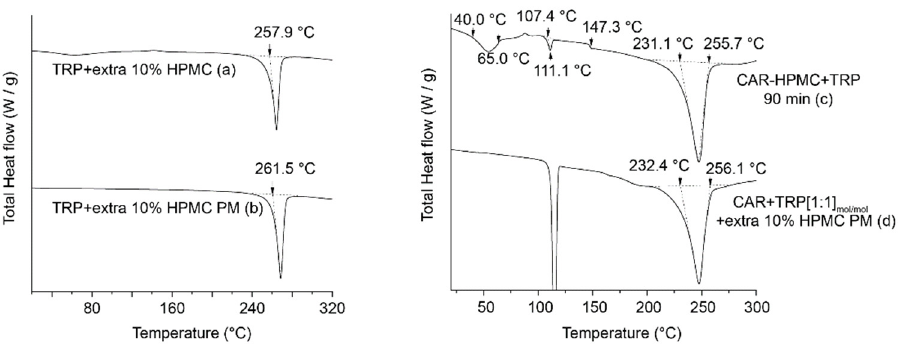
Figure 5. DSC thermograms of ( a ) TRP-HPMC at the milling endpoint; ( b ) TRP + extra 10% w / w HPMC physical mixture. The onset temperatures of the melting endotherm are indicated by arrows. DSC thermograms of ( c ) CAR-HPMC + TRP 90 min samples; ( d ) CAR + TRP [1:1] + extra 10% HPMC PM. The T m s and T g are indicated by arrows.